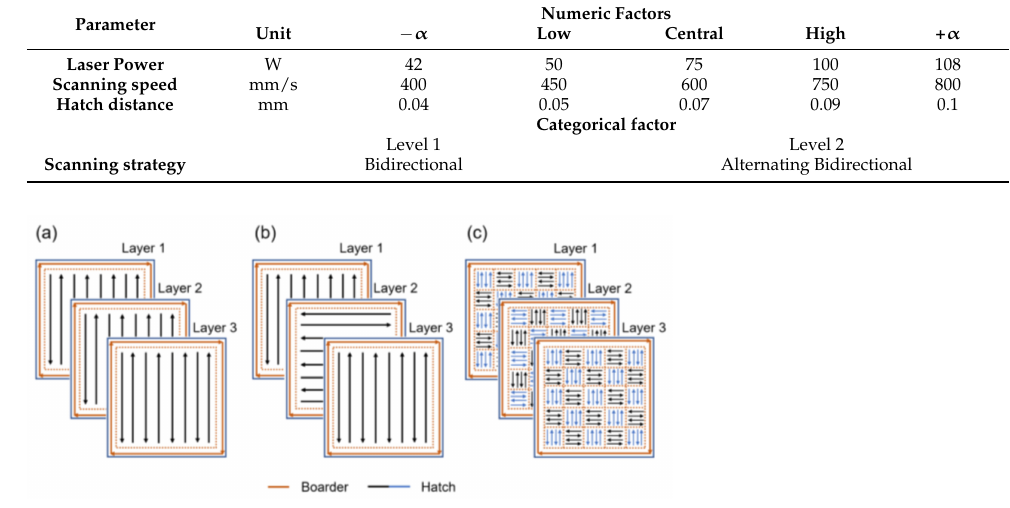
Figure 2. Different LPBF scanning strategies used for processing of Inc718; ( a ) bidirectional, ( b ) alternating bidirectional, ( c ) alternating